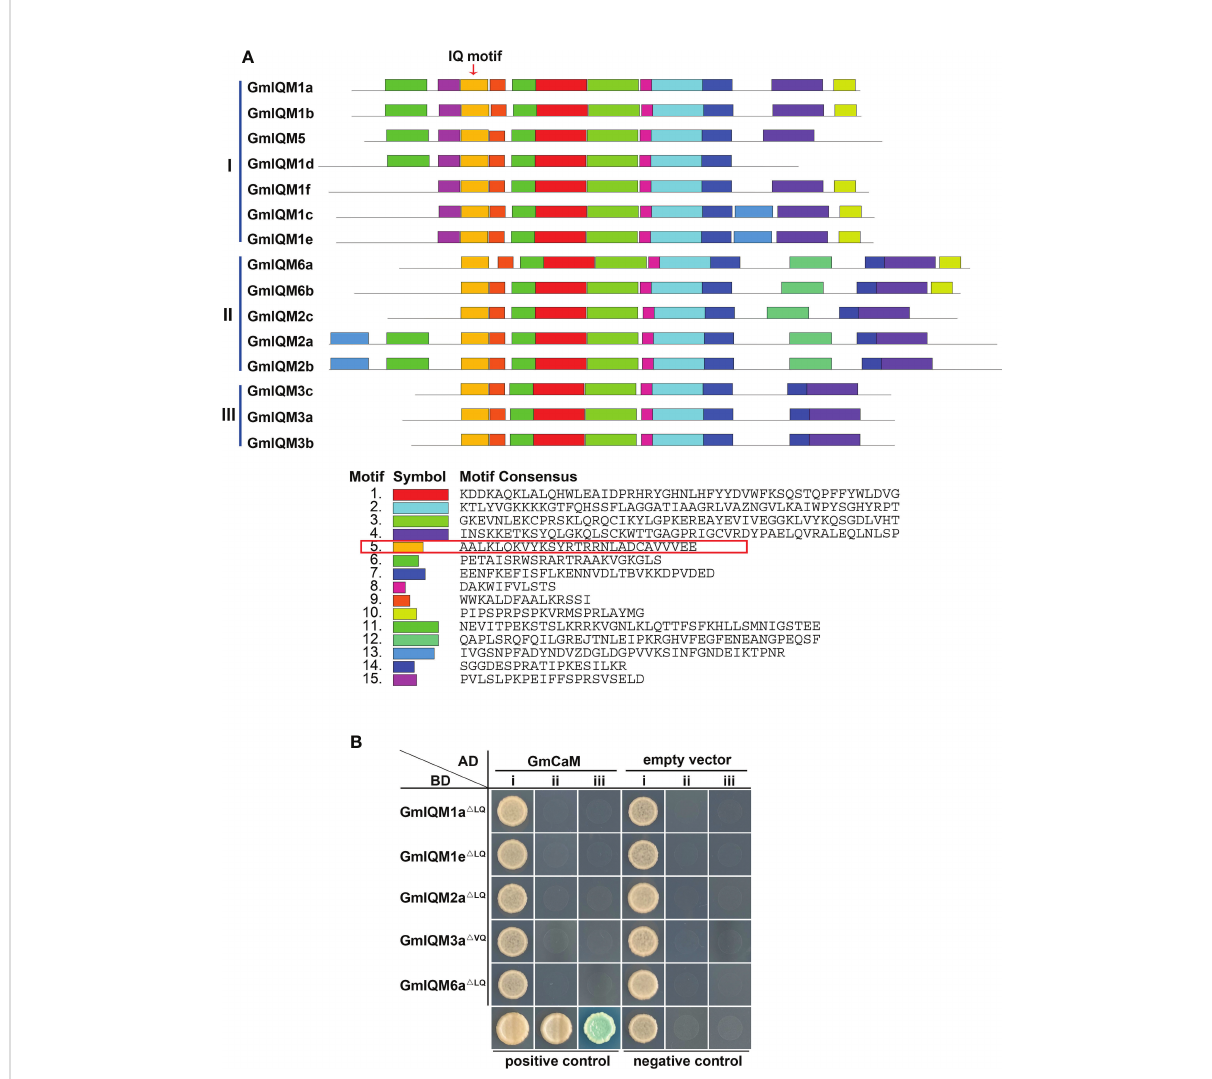
FIGURE 3 Conserved motif in GmIQM proteins. (A) Motif distribution in the IQM proteins of soybean. Motifs of the GmIQM proteins were identi fi ed using the MEME online program. The maximum number of motifs was set as 15. Fifteen motifs were represented by different colors; each motif consensus sequence is listed below, red box represents the amino acid sequence of the IQ motif, arrow above the diagram represents the location of the IQ motif. (B) Functional validation of the IQ motif in GmIQM proteins. AD-GmCaM and BD-GmIQM LQ/VQ were co-transformed into yeast cell AH109 grown on SD/-Trp-Leu (i), SD/-Trp-Leu-His (ii), and SD/-Trp-Leu-His-Ade containing 20 m g/ml x- a -gal (iii) for 3 days. Co- transformation with the AD empty vector and BD-empty vector was performed for use as the negative controls. AD-AtCAT2 and BD-AtIQM1 served as the positive